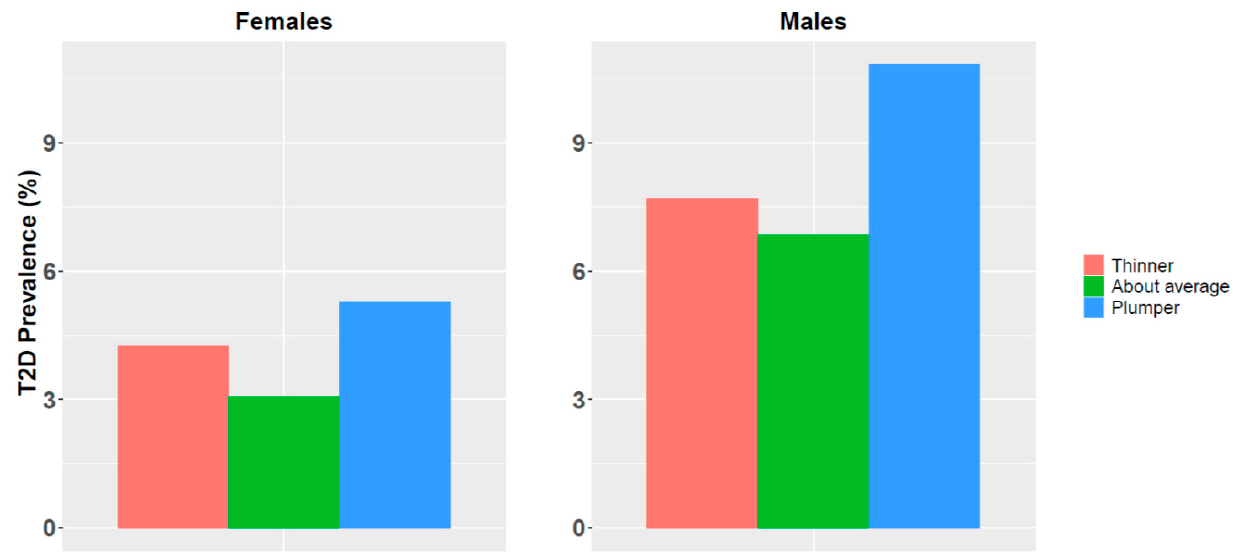
Figure 4. T2D disease prevalence for different categories of body size at age ten for females and males.